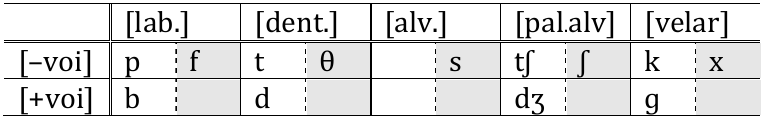
Table 3: The obstruents of Old English.